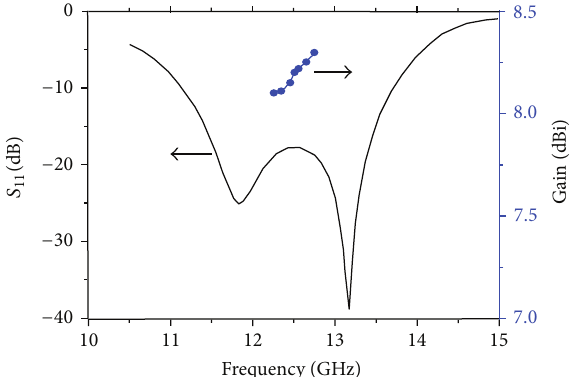
Figure 8: The reflection coefficient and gain of the element.